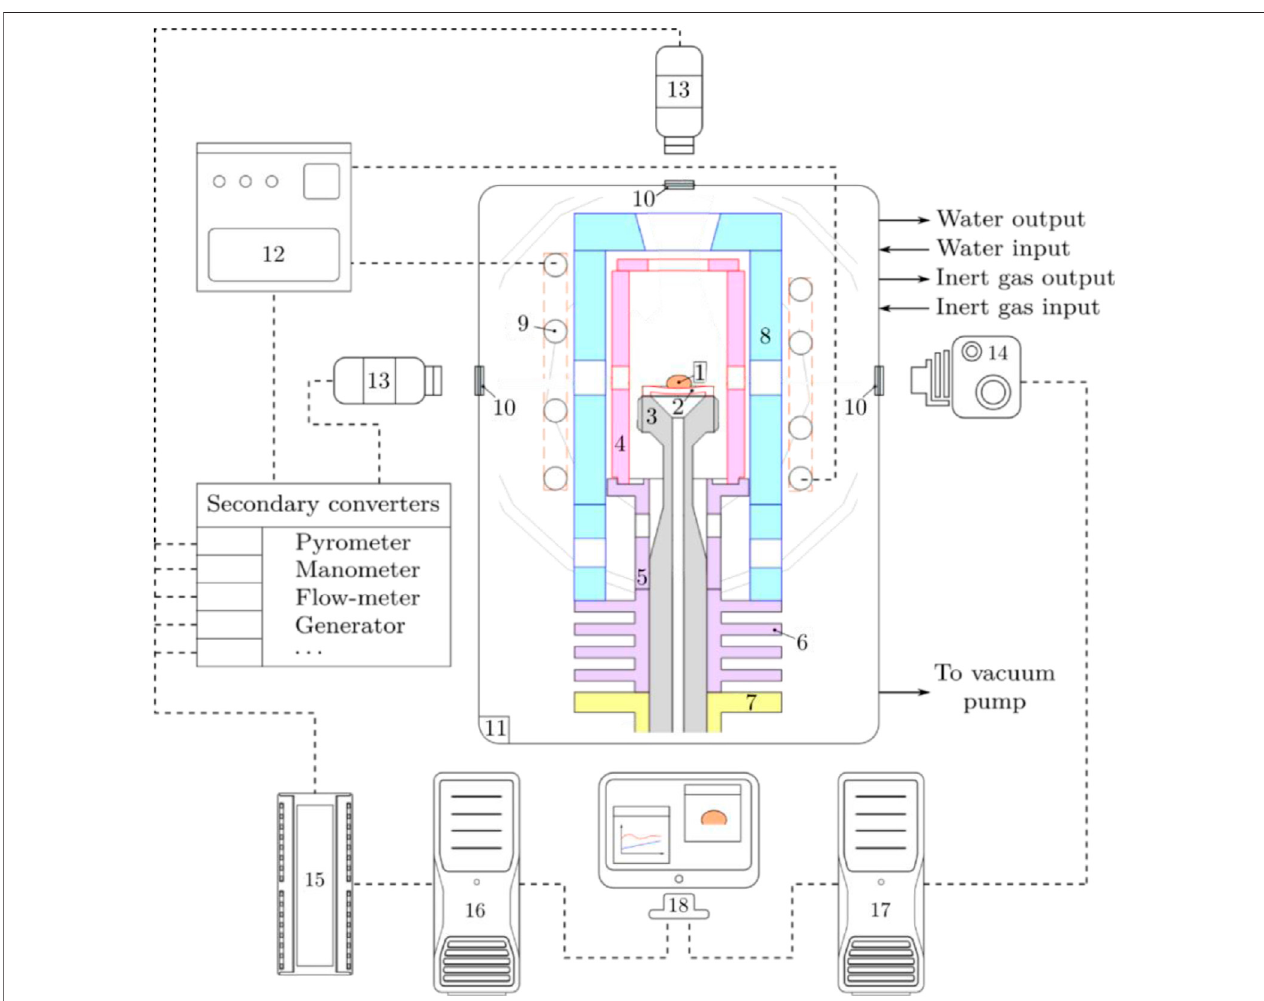
FIGURE 1 | Overall layout of VITI-SD con fi guration (Chikhi, et al., 2019). 1: liquid droplet; 2: substrate; 3: substrate support; 4: susceptor; 5: susceptor support; 6: fi ns; 7:globalsupport; 8:thermalshield; 9:inductor;10:windows; 11:con fi nement vessel;12:generator;13:pyrometers;14:camera;15:databus;16:acquisition PC; 17: imaging PC; 18: